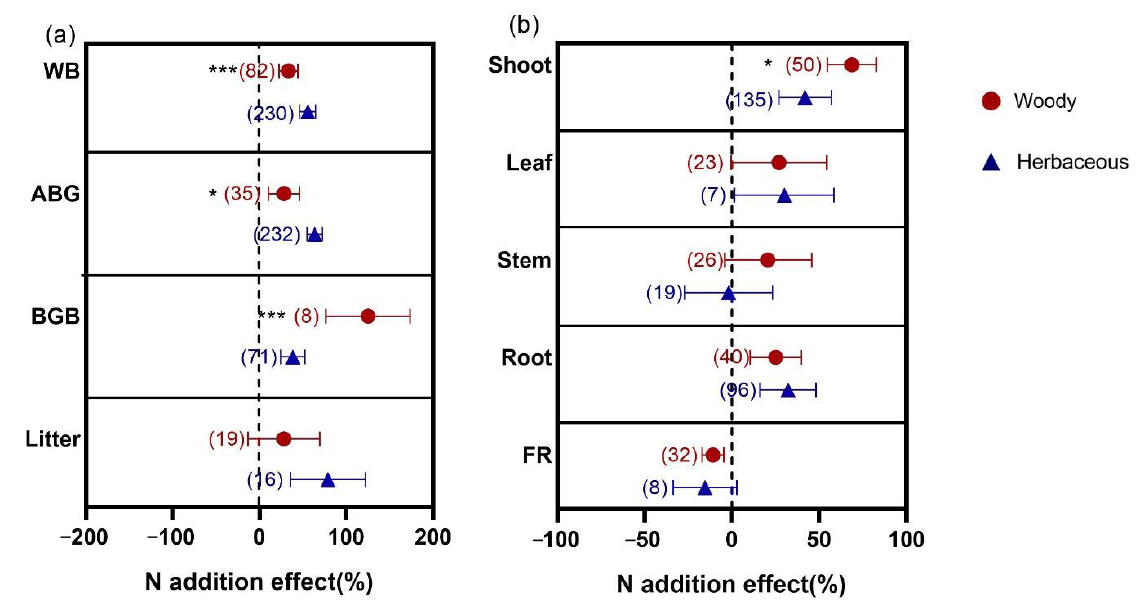
Figure 4. Effects of N addition on WB, AGB, BGB and litter biomass ( a ) and biomass of shoot, leaf, stem, root and FR ( b ) in Woody and Herbaceous in AM. AM means arbuscular mycorrhizal type with typical AM structures. The symbols represent the average of the 95% confidence intervals (CIs). The effect is considered to be significant when the 95% CI does not overlap with zero. The chi-square test was used to test the heterogeneity of all index effects between AM and ECM plants (*** p < 0.001 and * p < 0.05). WB, whole plant biomass; AGB, aboveground biomass; BGB, belowground biomass. FR, fine root. The number in parentheses represent the sample size of observations.